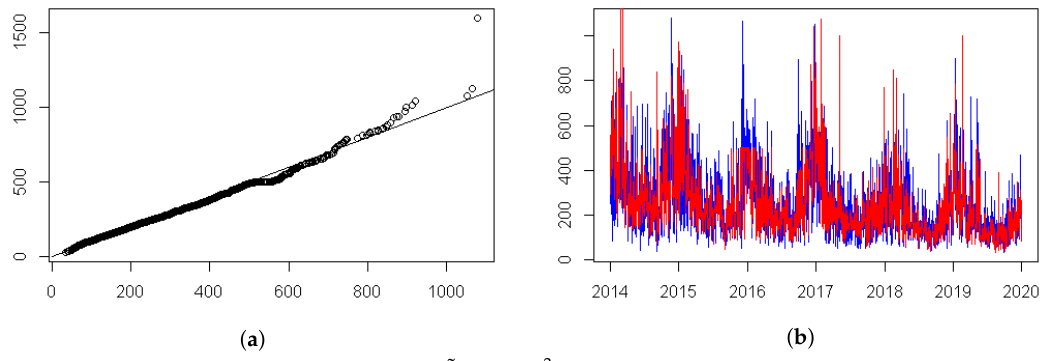
Figure 8. ( a ) The quantile-quantile plot of ˜ Q t ( µ g/m 3 ) using our DCW model ( x -axis) with real values Q t ( y -axis, µ g/m 3 ), and ( b ) time series plot and the comparison between ˜ Q t (blue lines, µ g/m 3 ) and real values Q t (red lines, µ g/m 3 ).